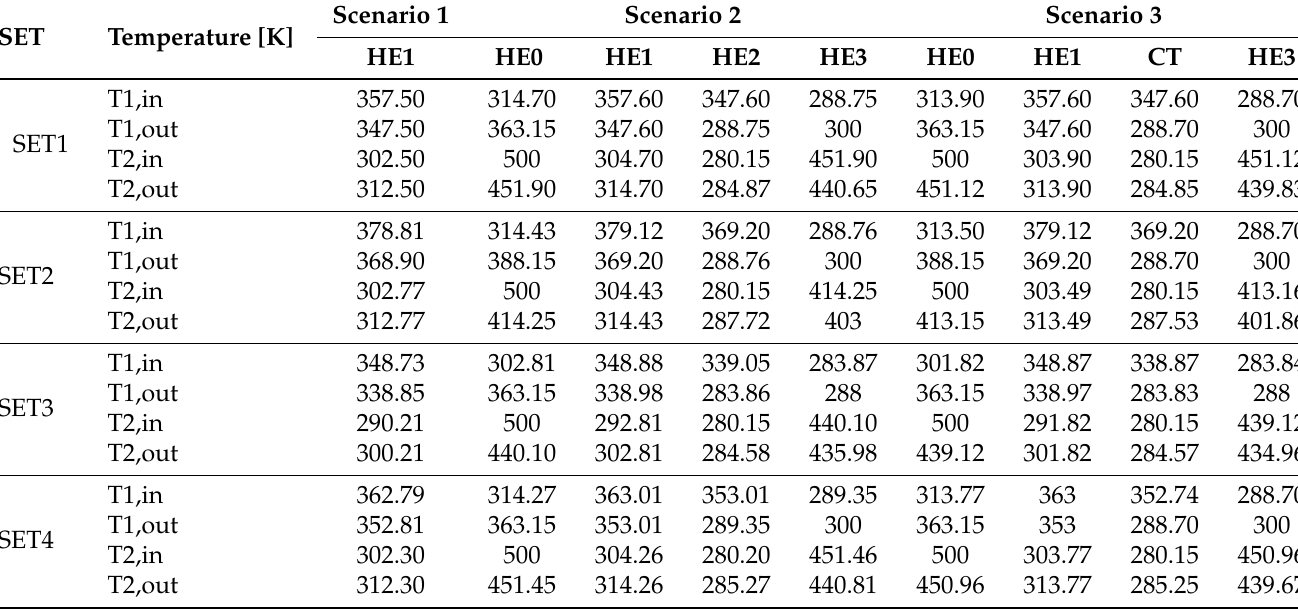
Figure 14. Total exchange surfaces varying among the different sets and scenarios. Table 2. The inlet and outlet temperatures of the heat